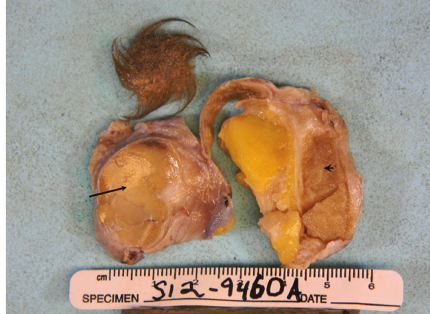
Figure1:Grossphotographoftheovariantumor,thearrowshowing the neuroendocrine (carcinoid) component, and the arrowhead showing the ependymoma component.